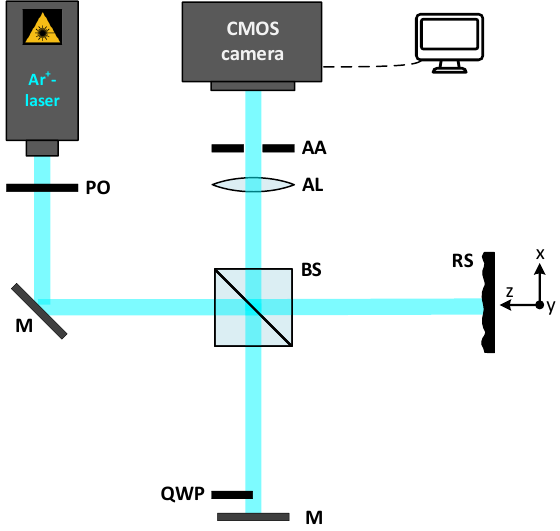
Figure 1. Experimental setup. PO: polarizer; M: plane mirror; BS: (non-polarizing) beam splitter; RS: rough surface; quarter wave platet (QWP): quarter wave plate; AA: adjustable aperture; AL: achromatic lens; CMOS: complementary metal-oxide